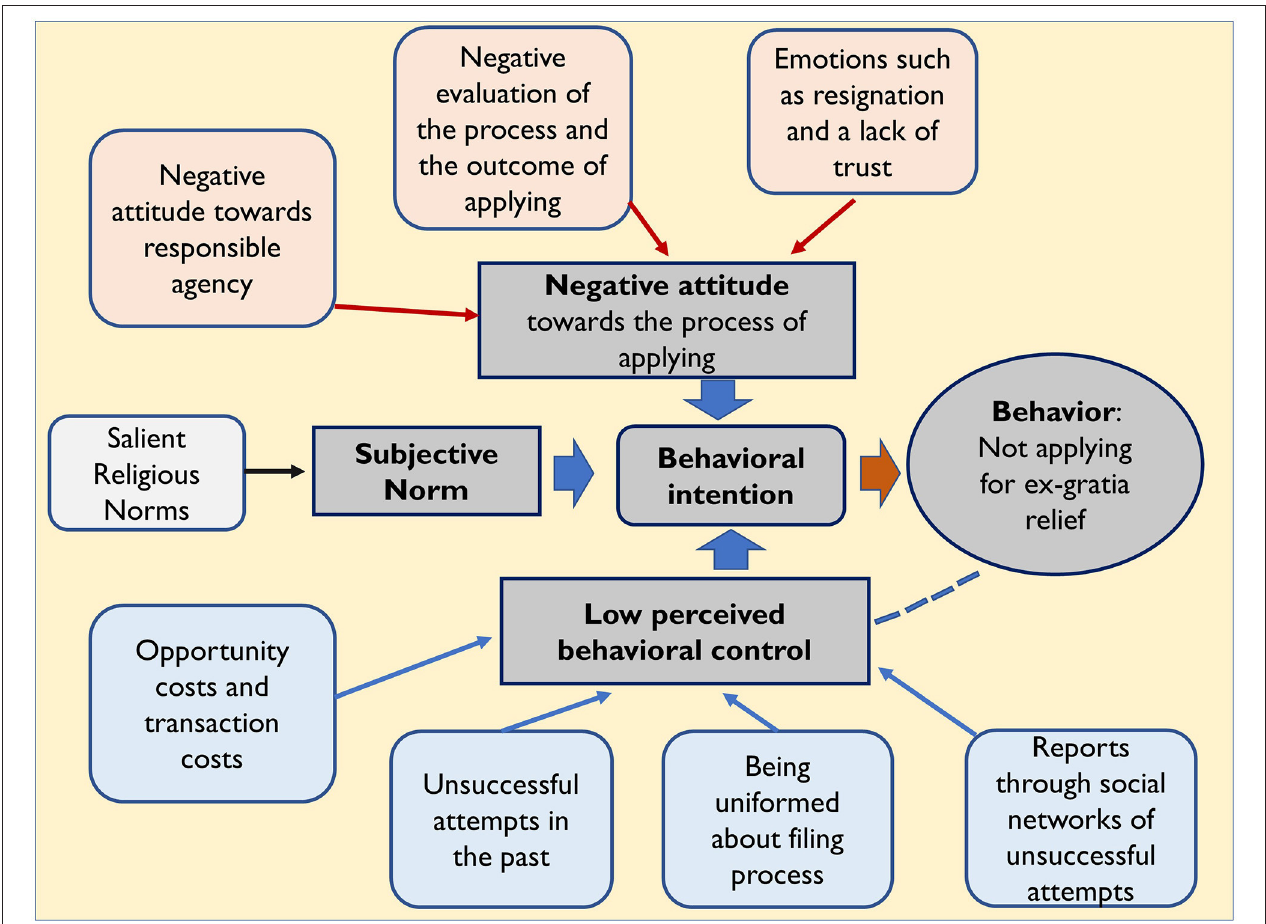
FIGURE 5 | Schematic model of the reasons based on the theory of reasoned action (TRA) and theory of planned behavior (TPB) for not claiming ex-gratia relief due to the wildlife caused